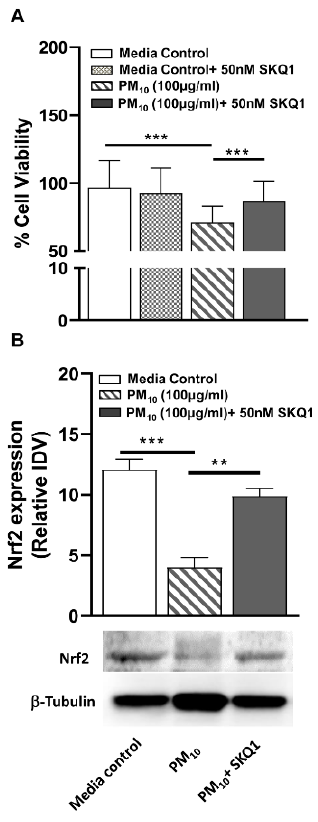
Figure 6. In vitro effects of SKQ1 on cell viability and Nrf2 levels after PM 10 exposure in primary human corneal epithelial cells (HCEC). ( A ) Loss in cell viability due to PM 10 exposure was signifi- cantly restored by SKQ1 pretreatment. ( B ) Western blot analysis for Nrf2 showed SKQ1 significantly increased Nrf2 levels after PM 10 exposure. Data are expressed as mean + SD (** p < 0.01, *** p < 0.001, n = 3).